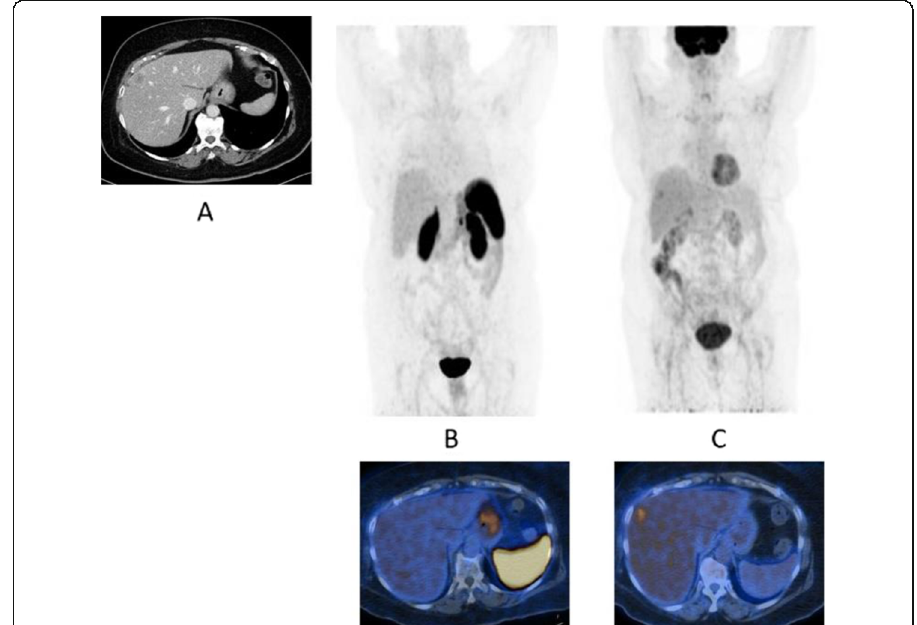
Fig. 54 68Ga-DOTA peptide, NET of the pancreas, suspicion of relapse, comparison with FDG. Clinical history : 63 y.o. man with known well differentiated pancreatic NET (Ki67:2%); routine follow-up CT detected a suspicious lesion in the liver ( a ); PET/CT was requested to restage the patient. PET/CT findings : 68 Ga- DOTANOC PET/CT shows only physiological uptake of somatostatin receptor analogue ( b MIP and fused PET/CT). FDG-PET/CT shows a mild pathologic uptake of the tracer in the liver and confirms liver involvement ( c MIP and fused PET/CT)